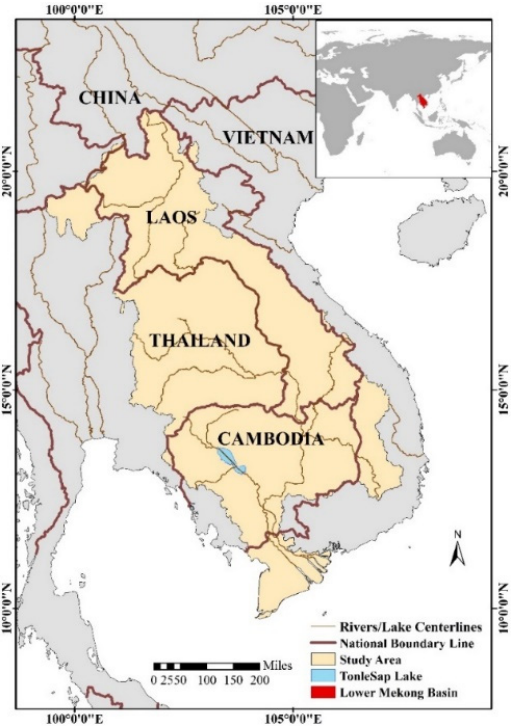
Figure 1. Study Area: The Lower Mekong River, the countries contained within the basin and national boundary lines.